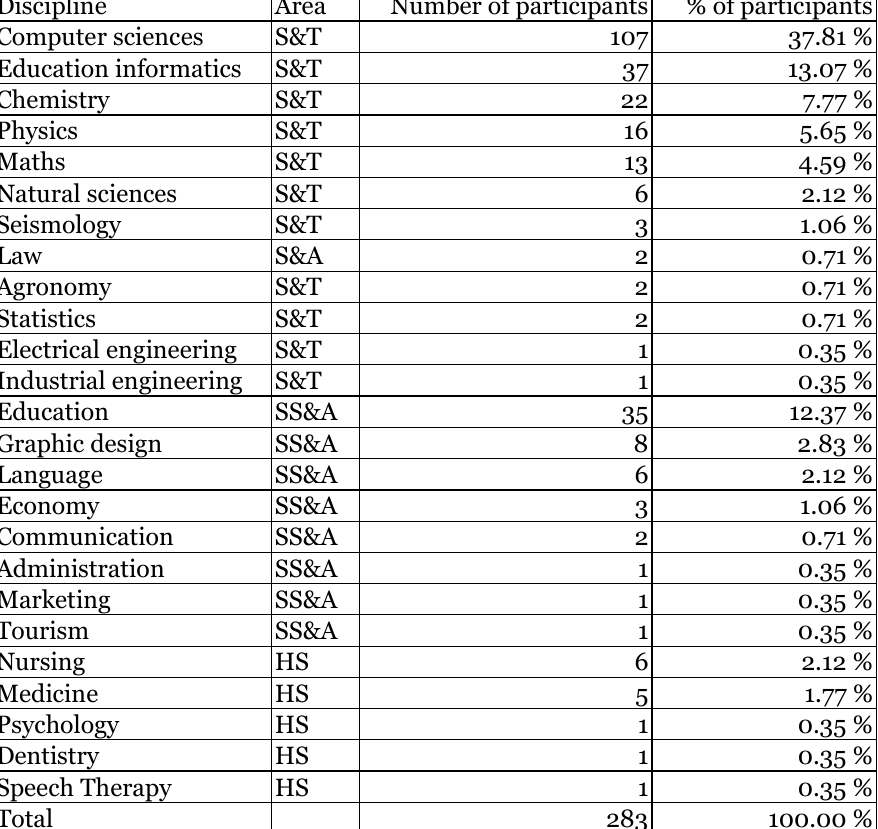
Population Distributed by